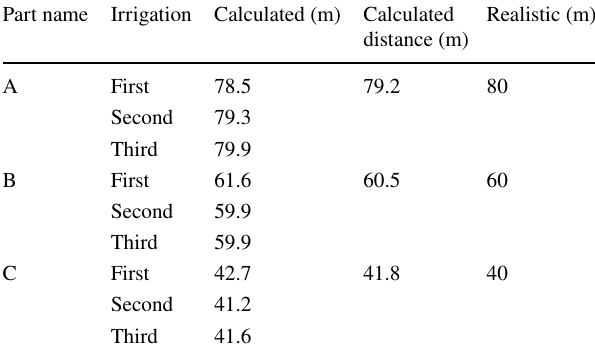
Table 4 Comparison between calculated and actual values which drains Part name Irrigation Calculated (m) Calculated